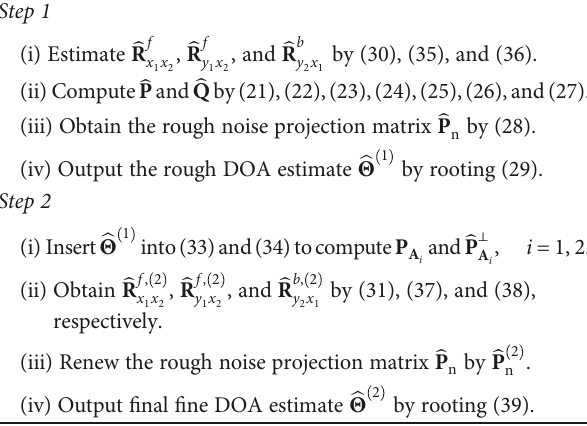
Table 1: The proposed two-step root-MUSIC algorithm.